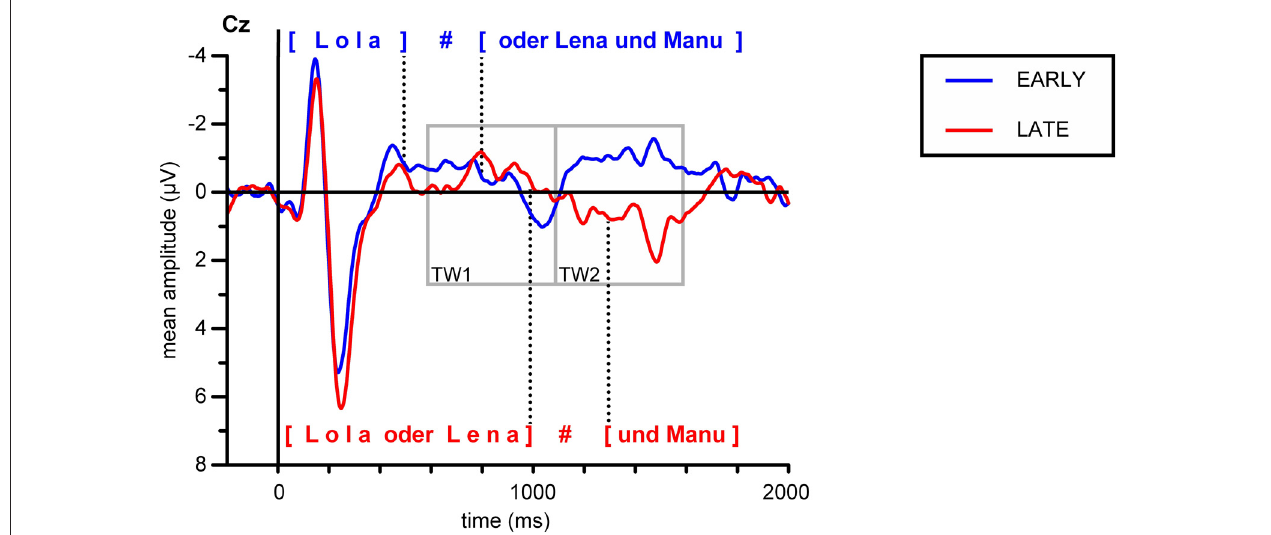
FIGURE 4 | Grand average ERPs for both conditions at electrode Cz. Gray boxes indicate the time windows used in the statistical analysis relative to stimulus onset. Dotted lines indicate the mean onset and offset of the pause at the IPB in the respective condition, the silent pause is indicated by a hash mark.